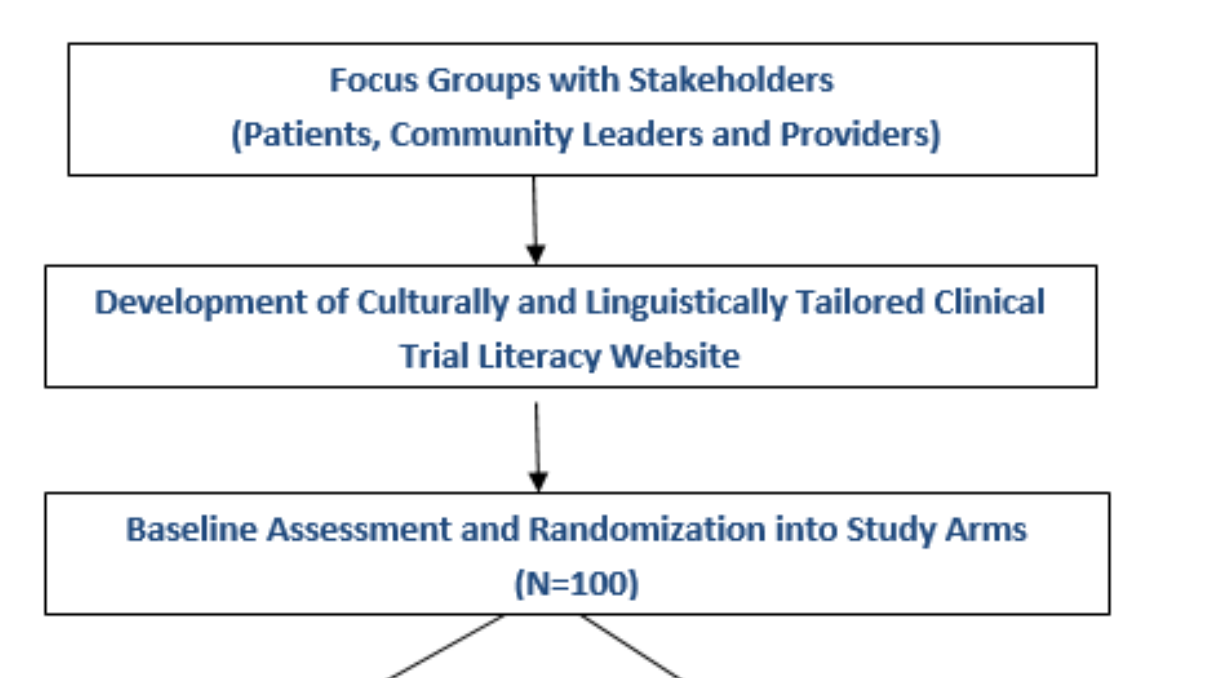
Figure 1. Study diagram illustrating participant flow throughout the study